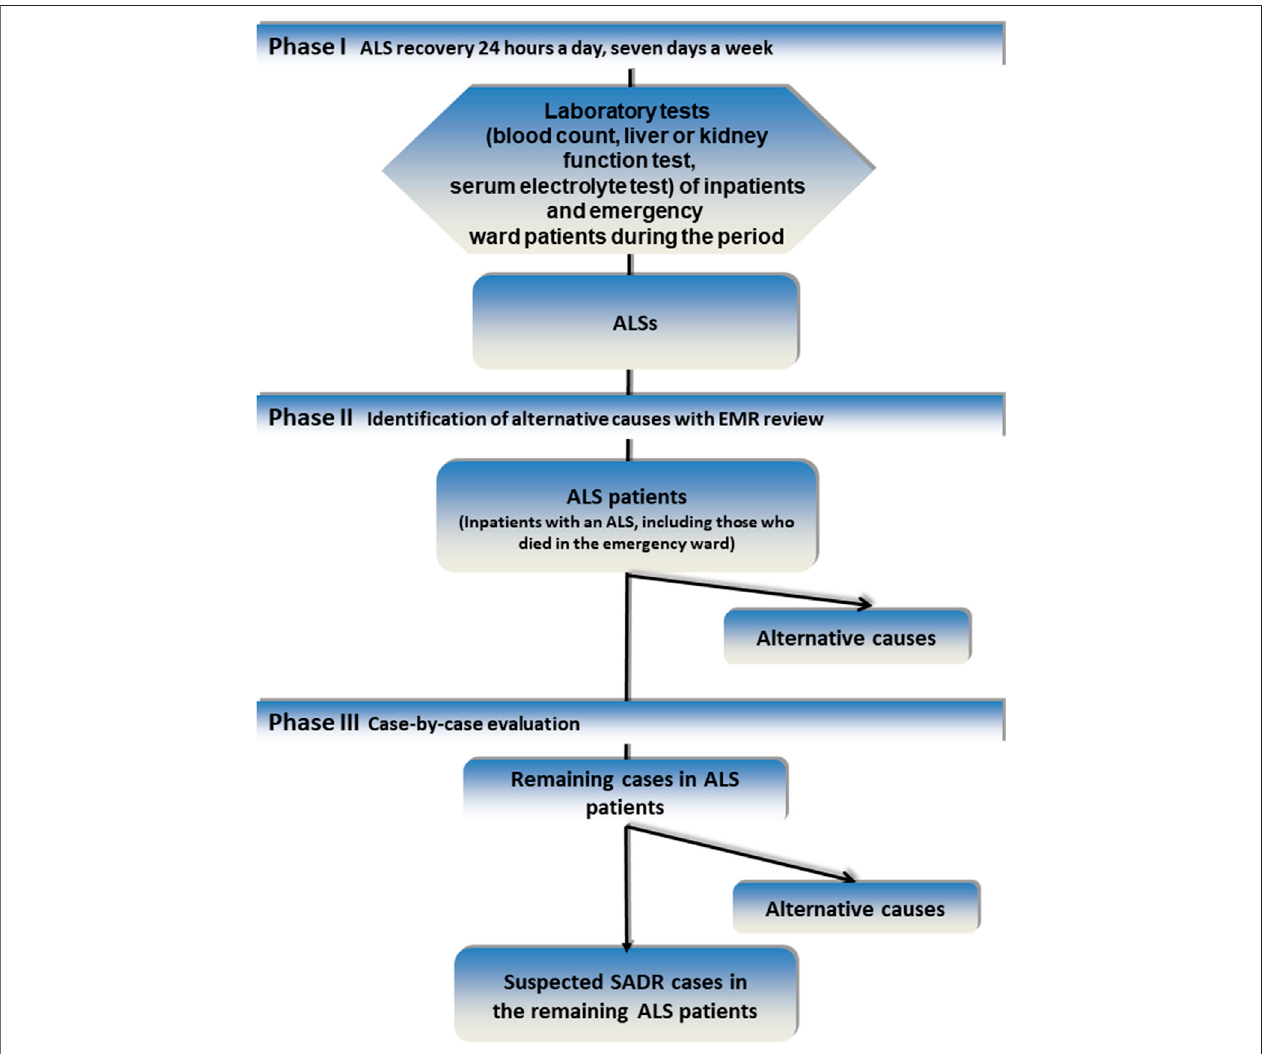
FIGURE1| MethodologyofthePharmacovigilanceProgramFromLaboratorySignalsinHospital.Abbreviations:ALS,automaticlaboratorysignal;EMR,electronic medical record; SADR, serious adverse reaction.